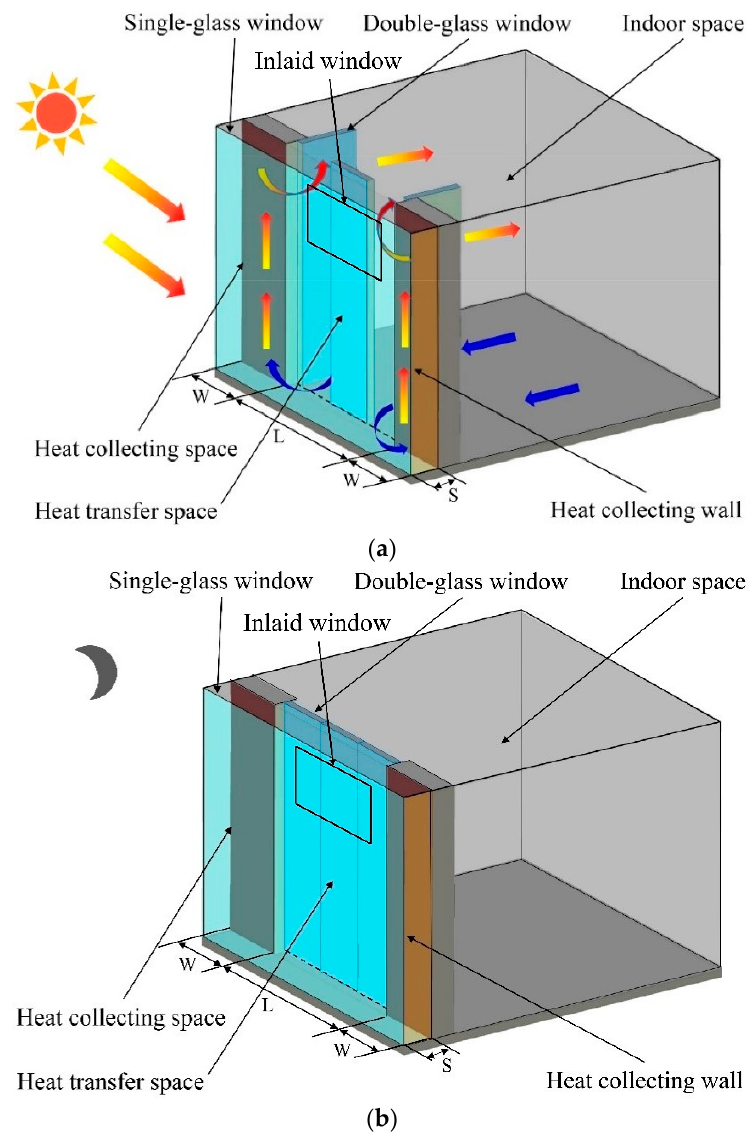
Figure 1. Schematic diagram of the hybrid heat collecting facade (HHCF). ( a ) with double-glass window open; ( b ) with double-glass window closed.